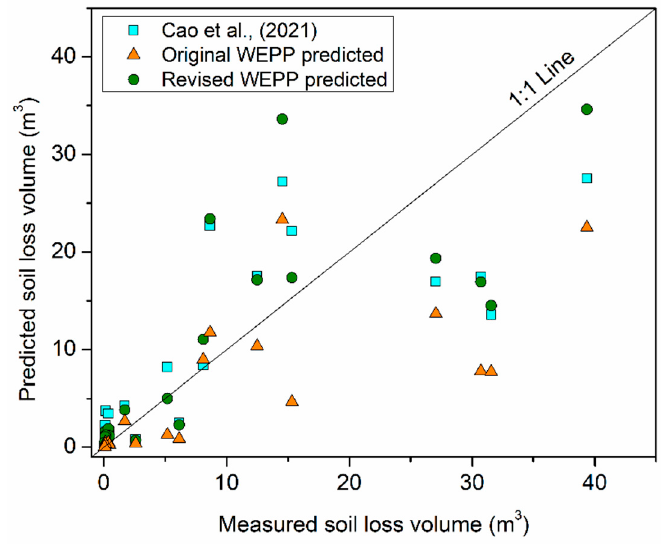
Figure 6. The efficiency of different predicted total road surface soil loss volumes. It could be seen that the revised WEPP predicted values are closer to the 1:1 line than the original WEPP values.